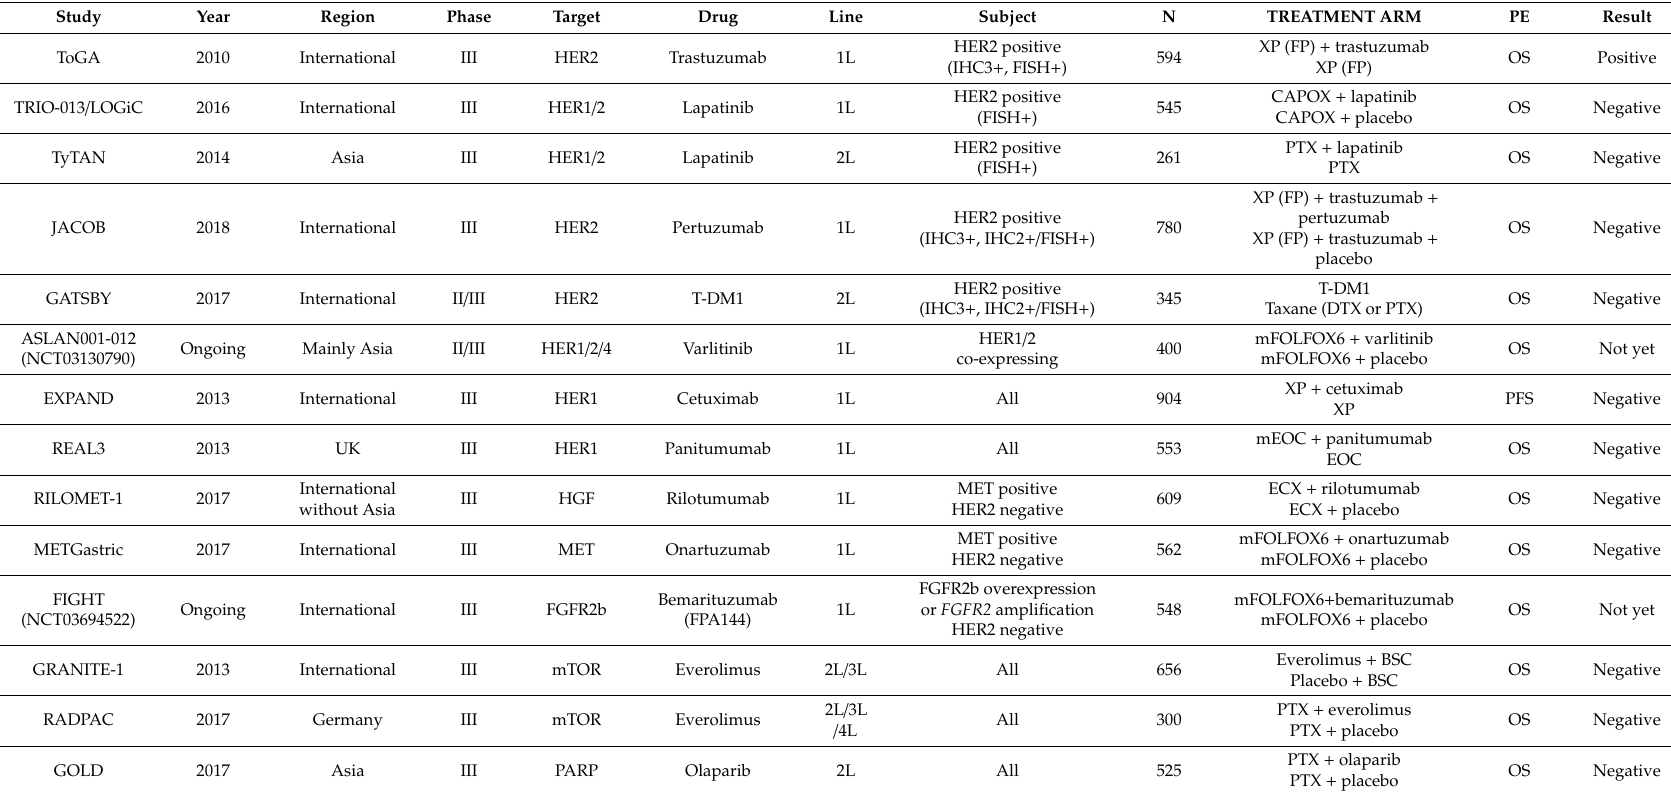
Table 3. Phase III (or II / III) trials of targeted therapy in advanced gastric